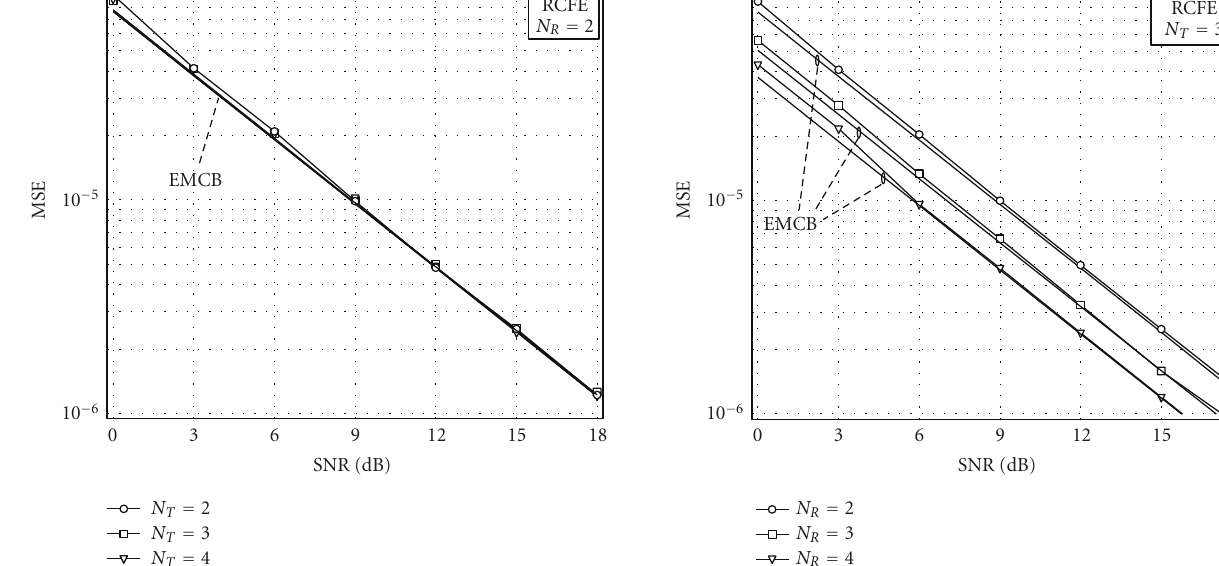
ease the reading of the graphs. The number of TX and RX